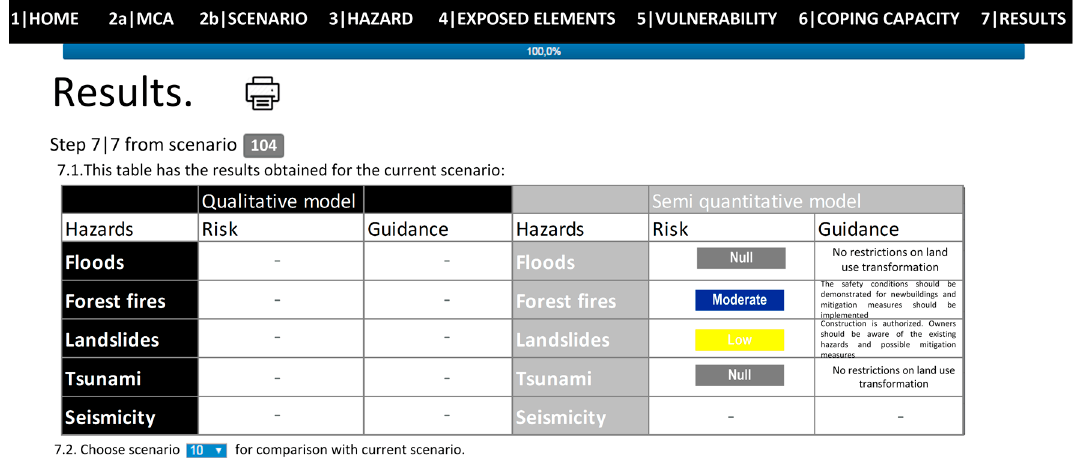
Figure 10. Results for the semi-quantitative risk analysis base scenario with an increase in the vulnerability component.